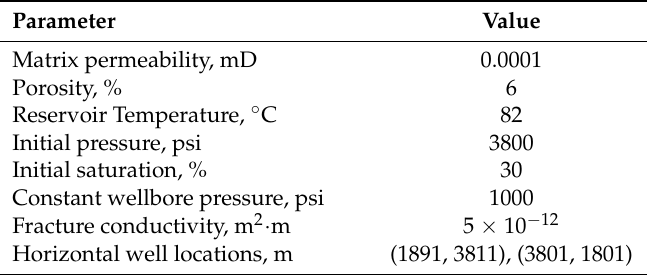
Table 2. Reservoir